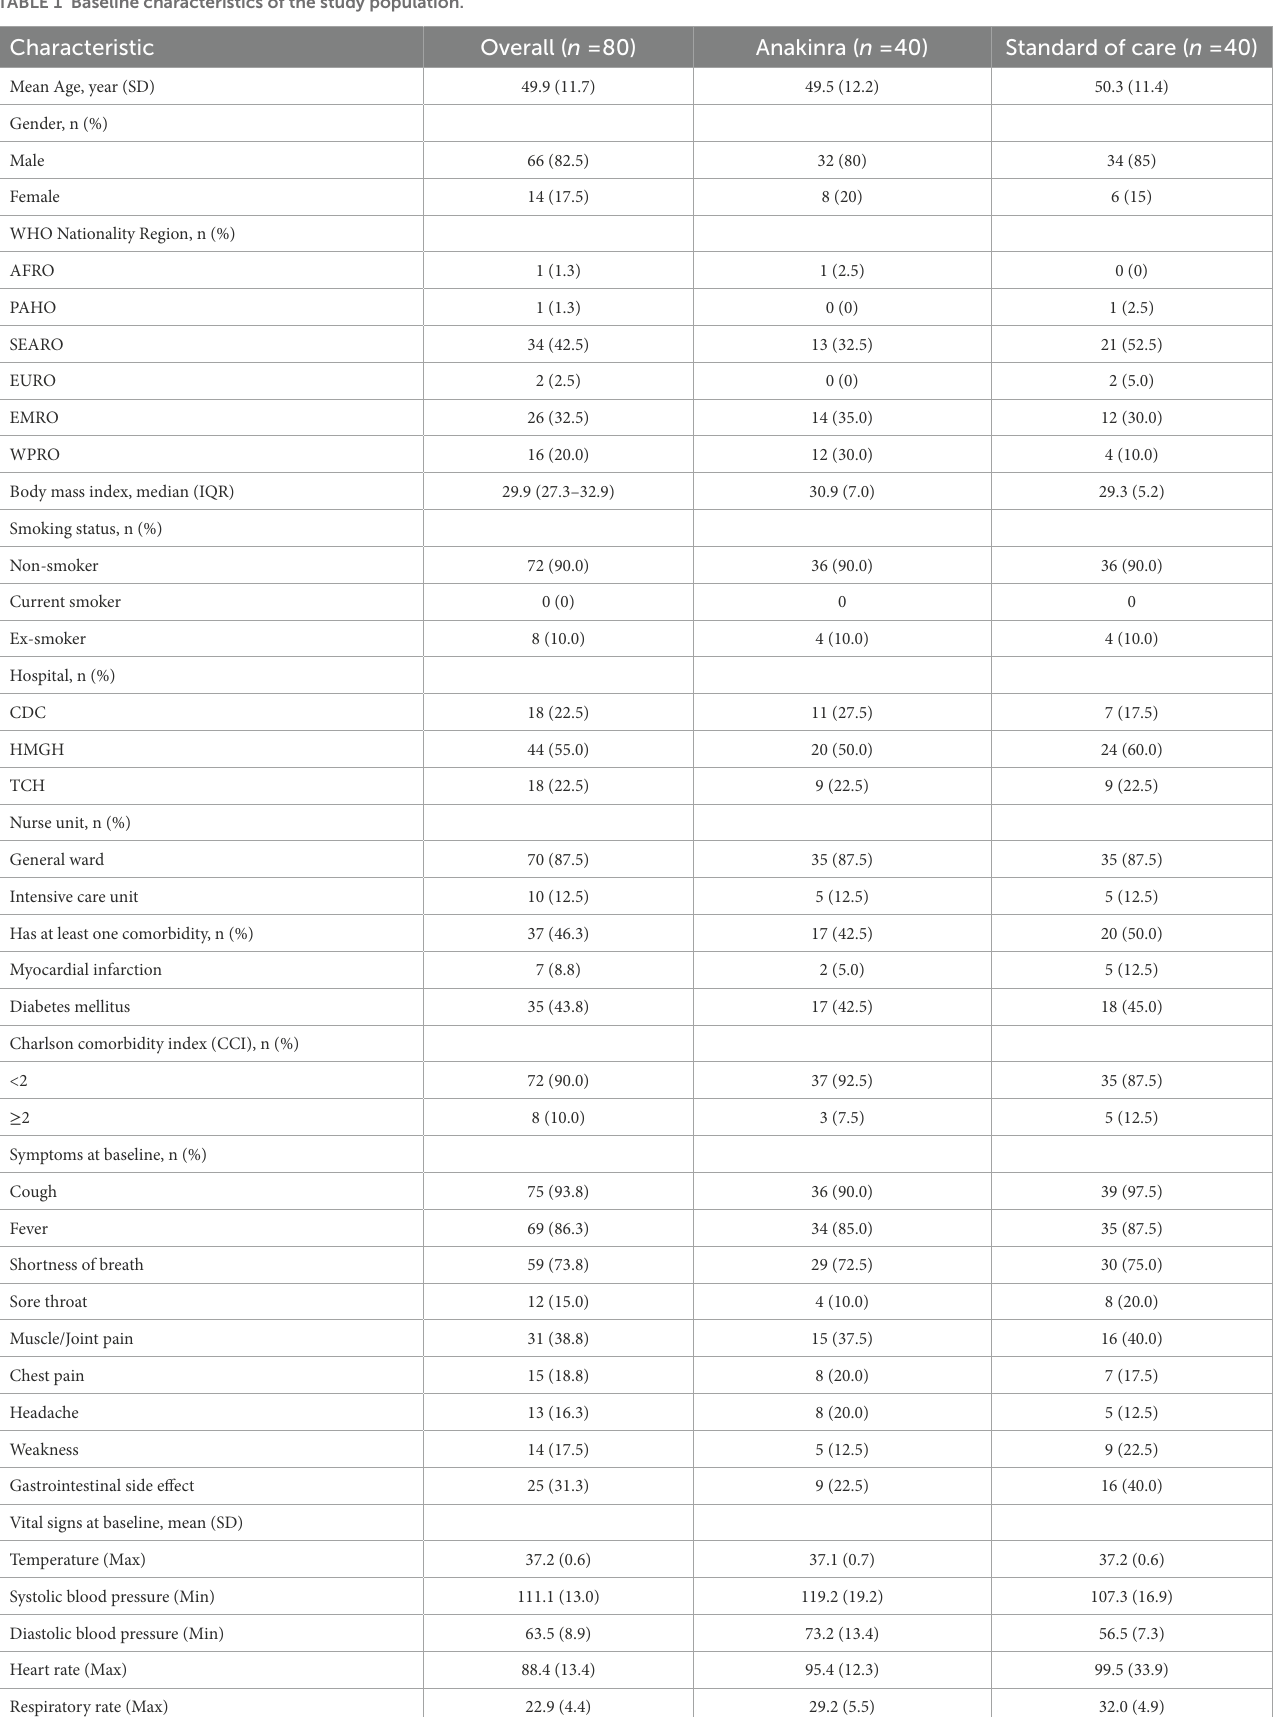
TABLE 1 Baseline characteristics of the study population. Characteristic Overall ( n =